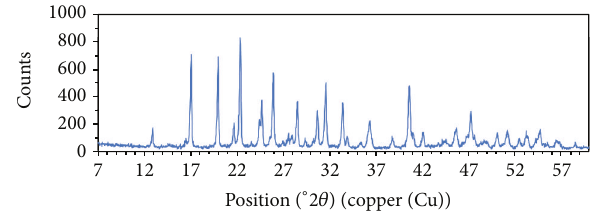
Figure 7: XRD pattern of MgB 4 O 7